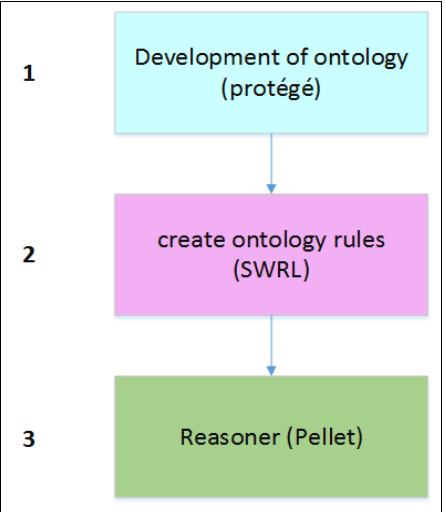
Figure 4. Adaptive ontological